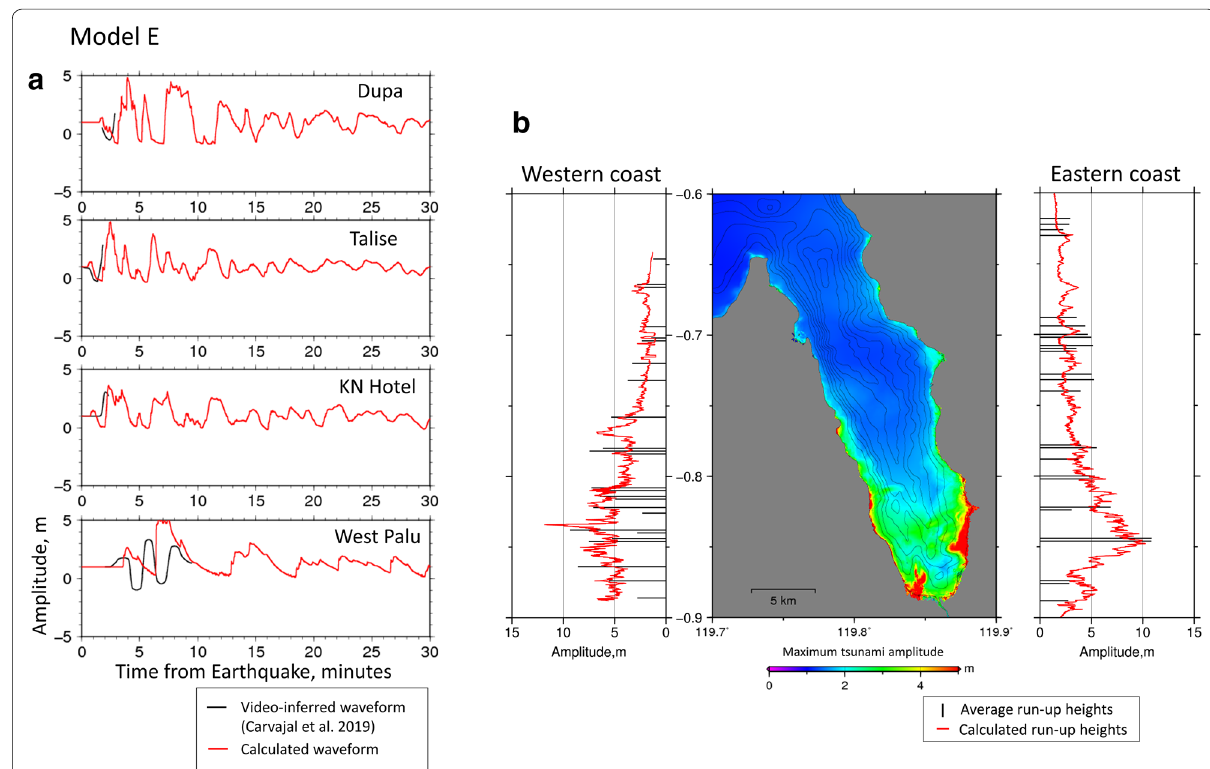
Fig. 7 Calculated tsunamis generated by the landslide source in the southern part of the bay (model E). Same as in Fig. 4 for source model